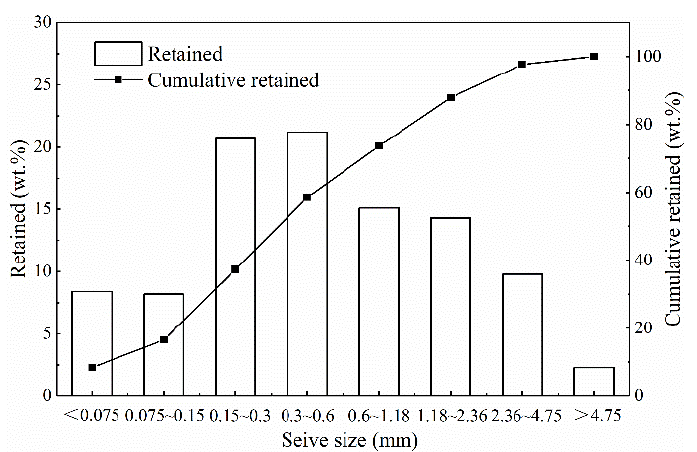
Figure 1. Sieve analysis results of coal gasification coarse slags.